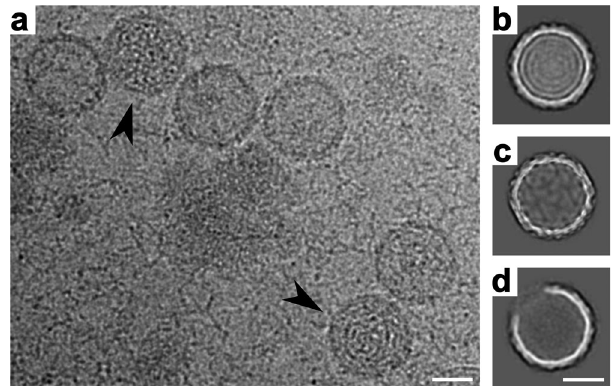
Fig. 1 Preparation of L-BC virus isolated from Saccharomyces cerevisiae contained full, empty, and open particles. a A selected cryo-electron micrograph showing full (arrowheads) and empty virus particles. The hair- like features in the background are probably formed by virus RNA released as a result of particle damage, and the gray blobs might be cell debris. Two- dimensional class averages of L-BC virion ( b ), empty ( c ), and open ( d ) particles. Scale bar 200